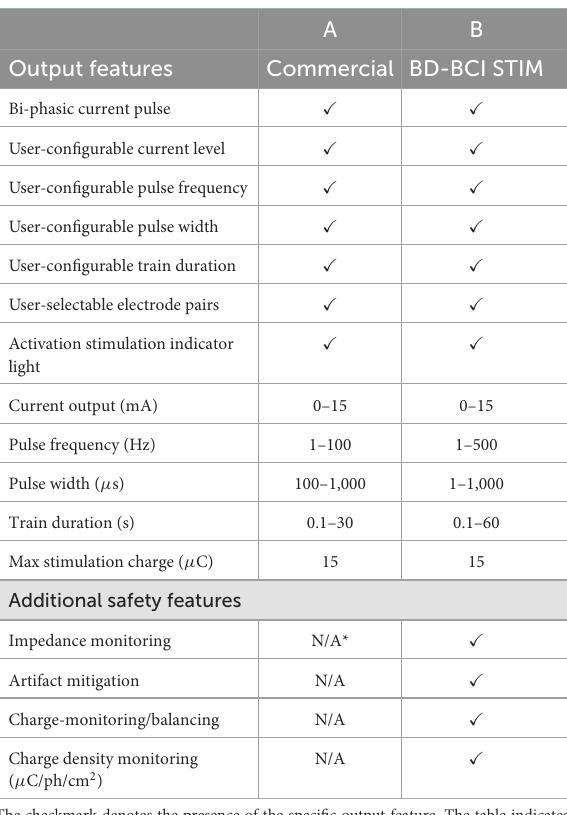
TABLE 2 The output equivalency table between the FDA approved commercial stimulator (A) and the BD-BCI stimulator